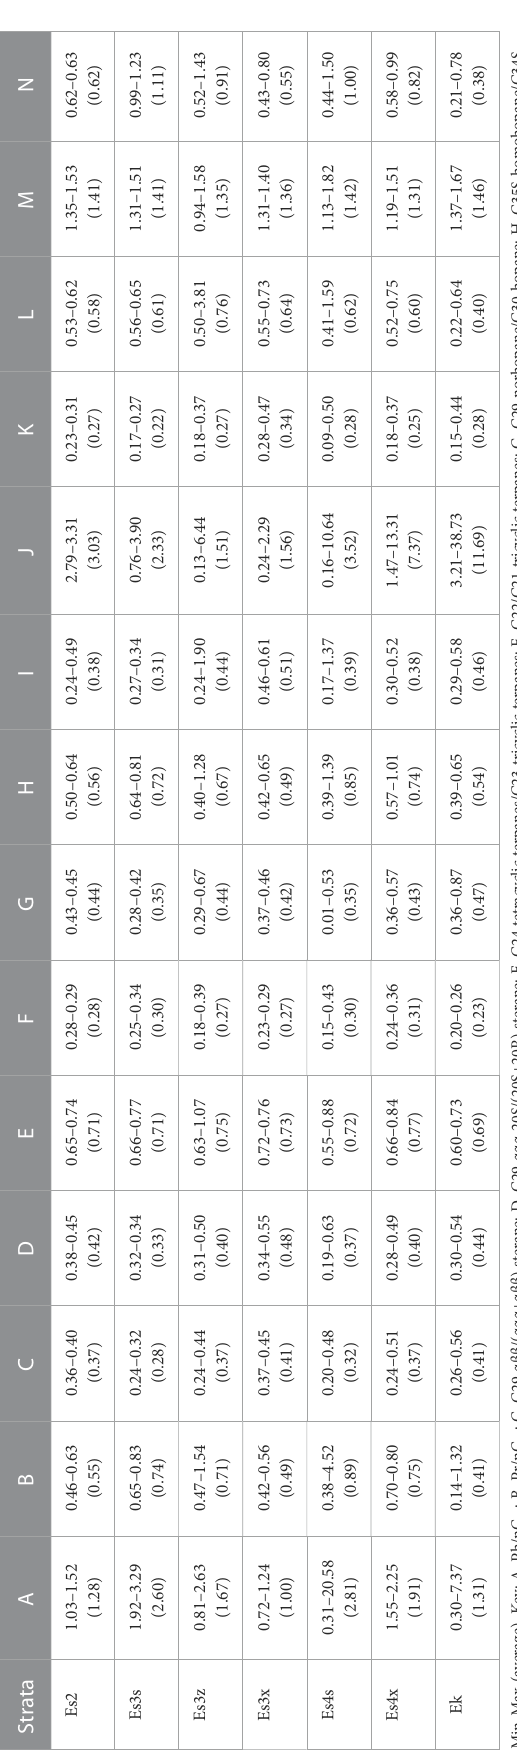
Figure 6 and Table 2 present representative mass chromatogramsof the aliphatic fractions for representative crude oil samples and the related biomarker ratios. Most of the crude oil samples show no biodegradation and have complete normal alkane distributions. However, crude oils in shallow reservoirs ( < 1,300 m) show slight biodegradation and mixing (Figure 6). For example, crude oil from well C104 experienced multiple episodic charges of varying